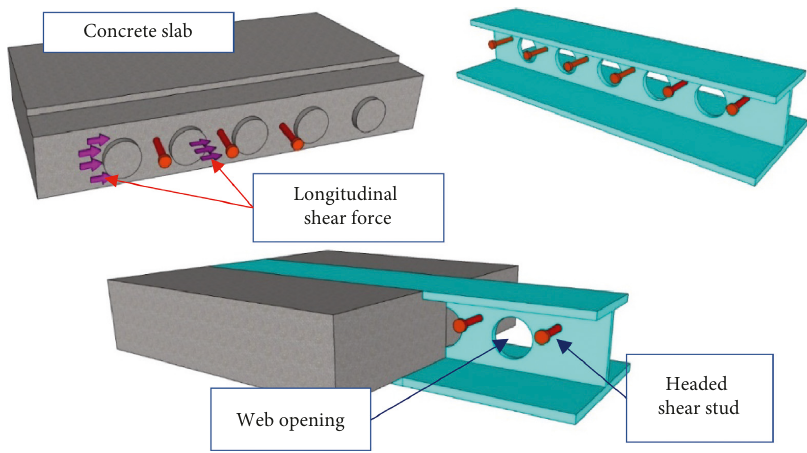
Figure 10: Web-welded shear stud connector for the shallow floor system.